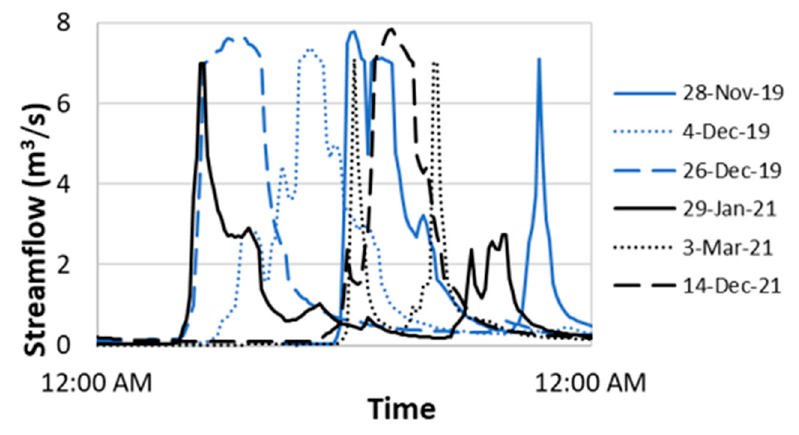
Figure A1. Del Cerro longitudinal slope.